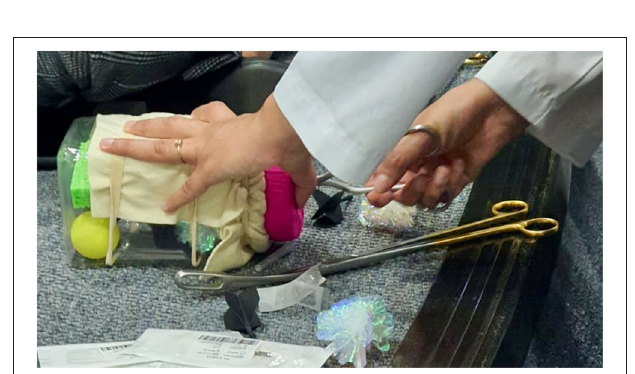
FIGURE 3 | D&E model in action with Bierer forceps used to extract “fetal